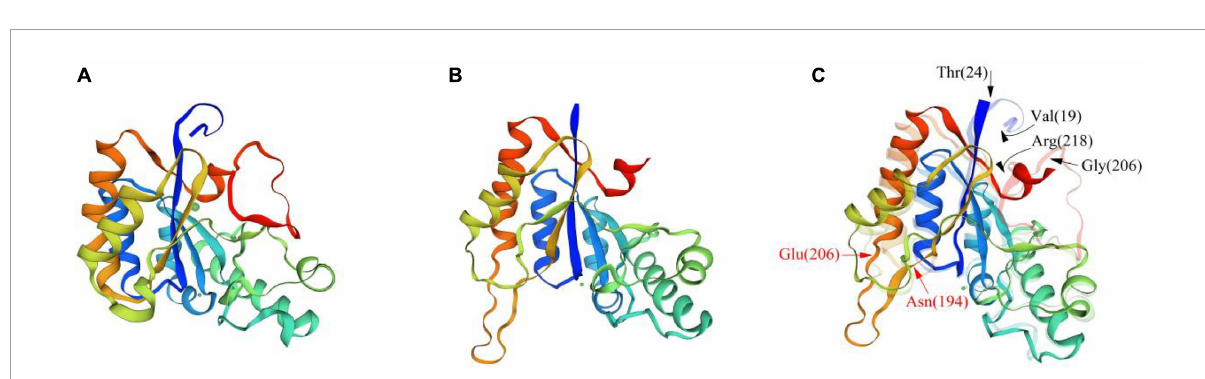
FIGURE7 Comparison of the tertiary structures of BaCDA and ArCE4A proteins. (A) Tertiary structure of ArCE4A protein of Arthrobacter sp. (5lfz.1. A). (B) Tertiary structure of BaCDA protein, using the crystal structure of ArCE4A protein from Arthrobacter sp. (5lfz.1. A) as template sequence. (C) Structure comparison between BaCDA and ArCE4A. The solid part was BaCDA tertiary structure, while the translucent was ArCE4A. Arrows indicated amino acid positions with structural differences between the two.